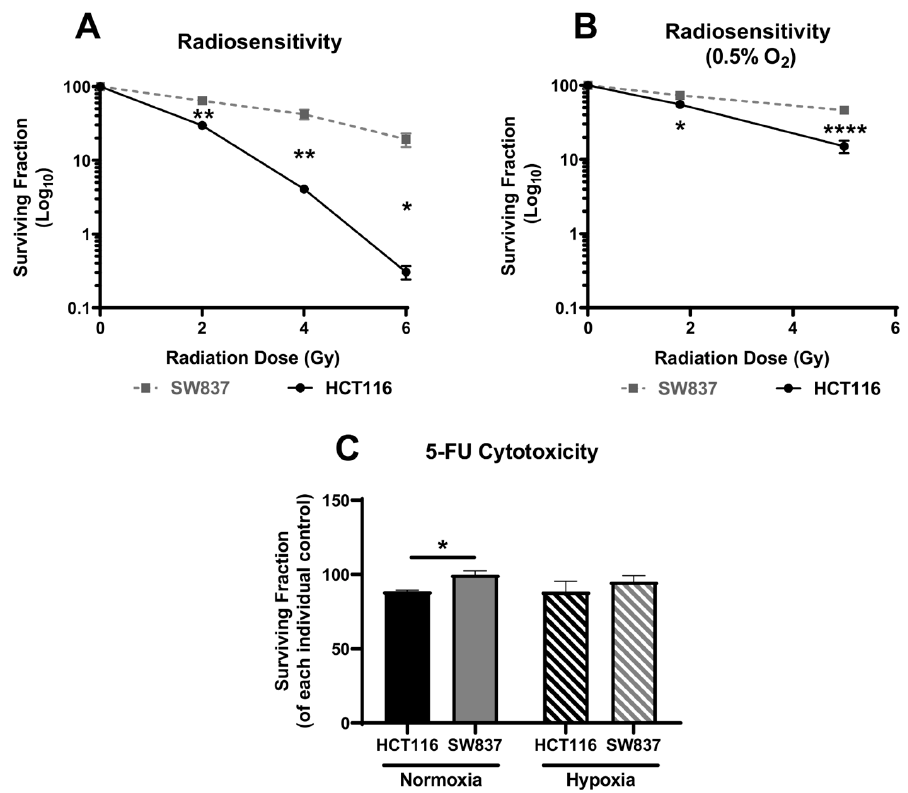
Figure 1. Identification of an in vitro model of inherently radioresistant/radiosensitive CRC. Clono- genic survival of HCT116 and SW837 cells treated with ( A ) X-ray radiation (2 Gy, 4 Gy or 6 Gy) under normoxia or ( B ) X-ray radiation (1.8 Gy or 5 Gy) under hypoxia or ( C ) 5-FU (15 µM, 30 h) or dimethyl sulfoxide (DMSO) vehicle control under normoxic or hypoxic conditions relative to controls, as as- sessed by the gold-standard clonogenic assay. Data are presented as means ± SEMs for at least three independent experiments. Statistical analysis was performed by t -testing or ANOVA, as appropriate. * p < 0.05, ** p < 0.01, **** p < 0.0001.